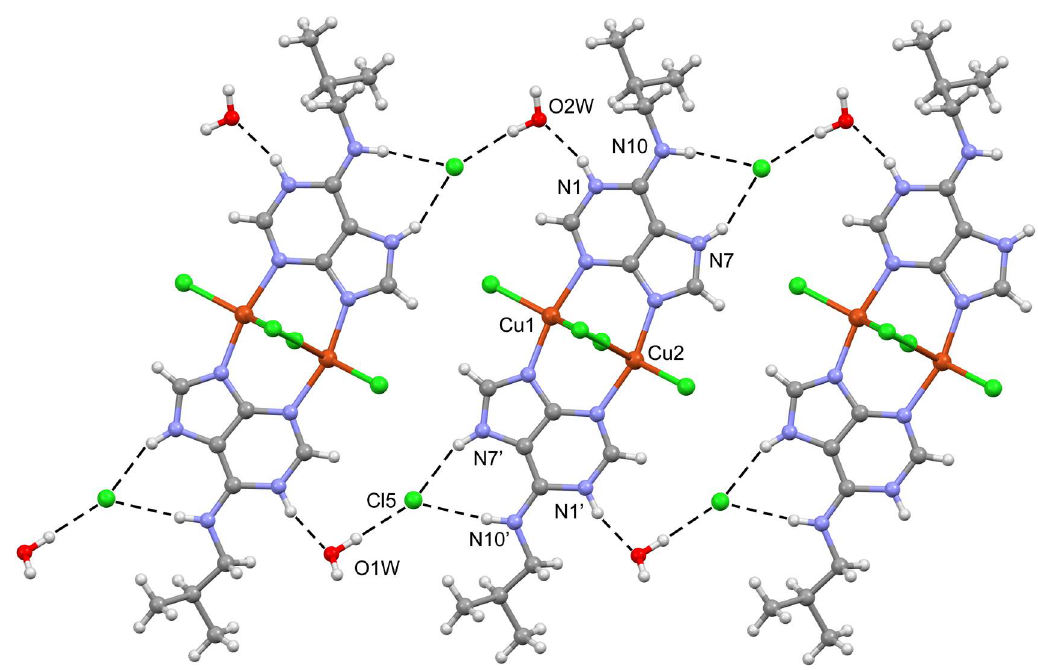
Figure 2. H-bonding network forming 2D supramolecular structures in compound 3 . See footnote of Table 1 for symmetry operations of N1′, N7′, and N10′.